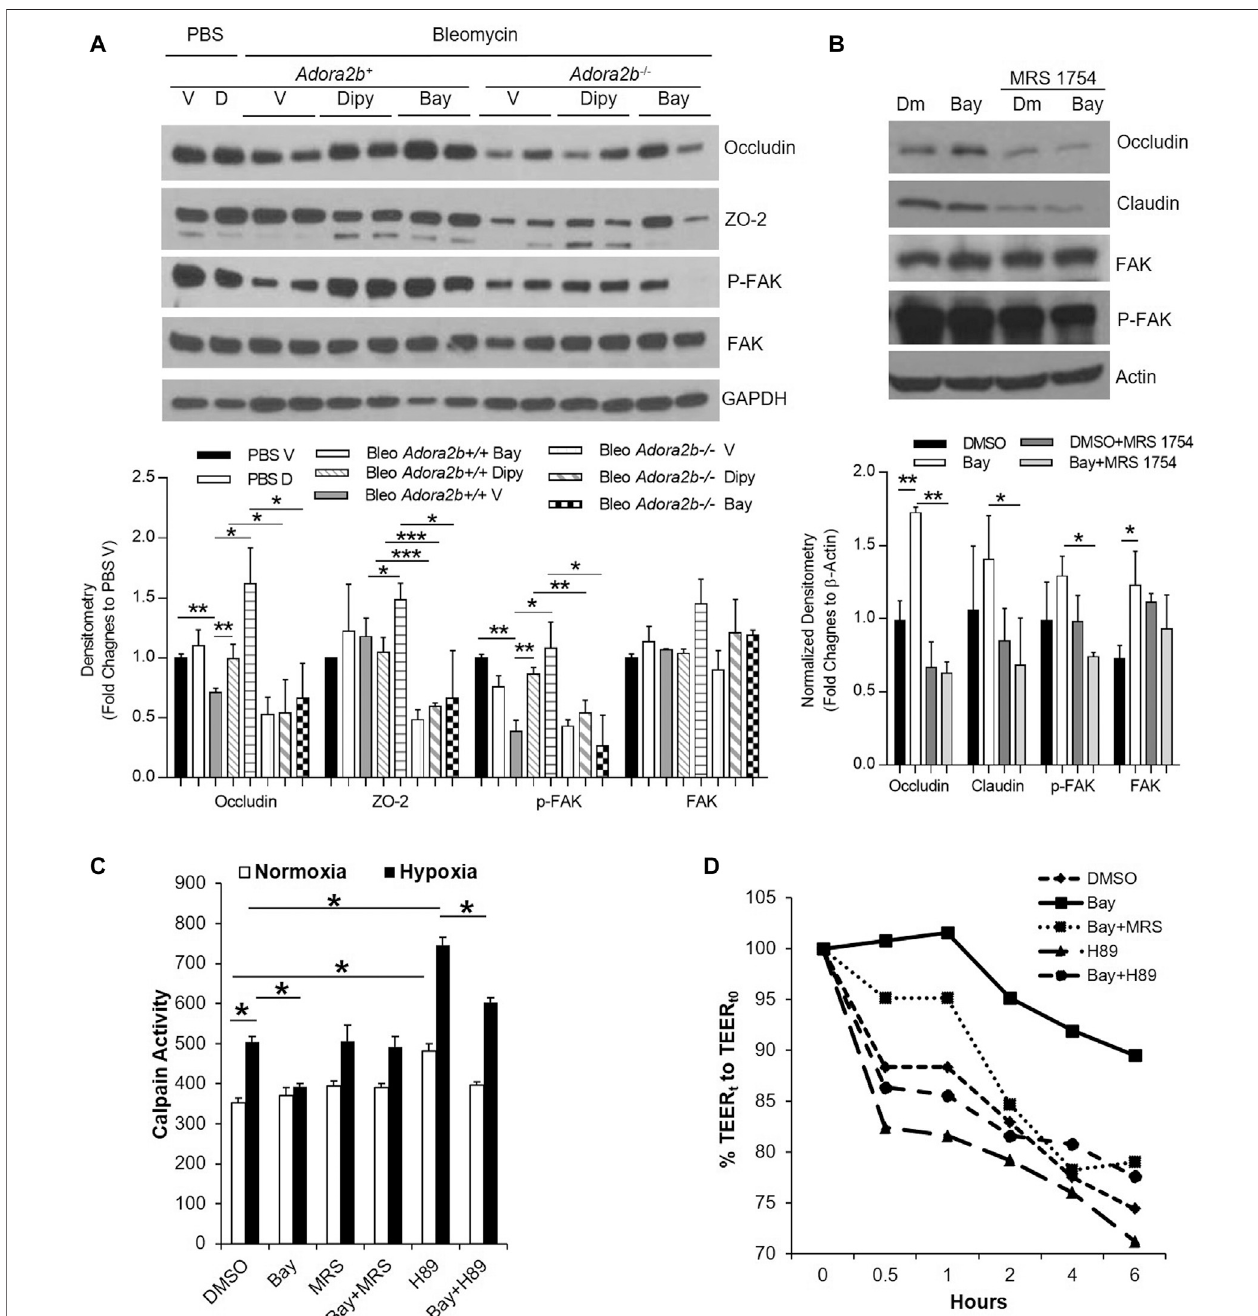
FIGURE 7 | The regulation of Adora2b on junction proteins. Adora2b +/+ or Adora2b − /- mice were I .t injected with 2.5 U/kg bleomycin. Two days later, mice were treated with 5 mg/kg dipyridmole twice daily or 500 ug/kg BAY 60-6583 daily until day 7 for analysis. (A) Upper panel: whole lung samples were collected from different treatmentgroupforwesternblotanalysisofOccludinandZO-2orphosphorylatedFAK( p -FAK)andFAK.Lowerpanel:TheDensitometryoftheWesternBlotimagewere analyzed.DatawerepresentedasFoldChangetoPBSVehicle ± SD.n ≥ 4,* p < 0.05,** p < 0.01.*** p < 0.001. (B,D,E) MLE12cellswereserumstarvedovernight, pretreatedwithADAfor30min,treatedwith500 nMBAY60-6583or1 µMMRS1754or10 μ MH89,andthenexposedto2%oxygenfor6 hforwesternblotand1 hfor Calpain activity. (B) Upper panel: Expression of Occludin and Claudin-1, and p -FAK and FAK were examined using western blot. Lower Panel: Densitometry of the Western Blot image were analyzed. Data were presented as Normalized fold changes to β -Actin ± SD. * p < 0.05, ** p < 0.01. (C) Calpain activities were measured and quantitated. * p < 0.05 one way ANOVA followed by Bonferroni ’ s multiple comparisons test vs. DMSO control. (D) RLE-6TN cells were serum starved overnight, pretreatedwithADAfor30min,treatedwith500 nMBAY60-6583or1 µMMRS1754or10 μ MH89,andthenexposedto2%oxygenfor0 – 6 h,transepithelialelectrical resistance (TEER) were measured and normalized to 0 h n (cid:2) 3 independent experiments.